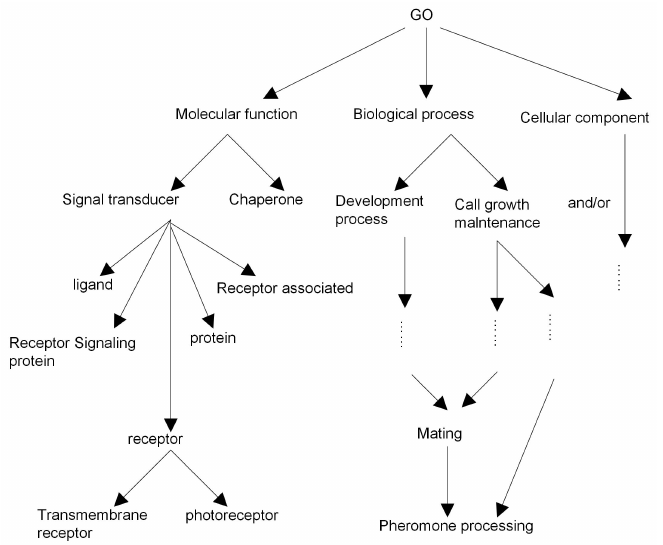
Fig. 1 The Structure of “GO”